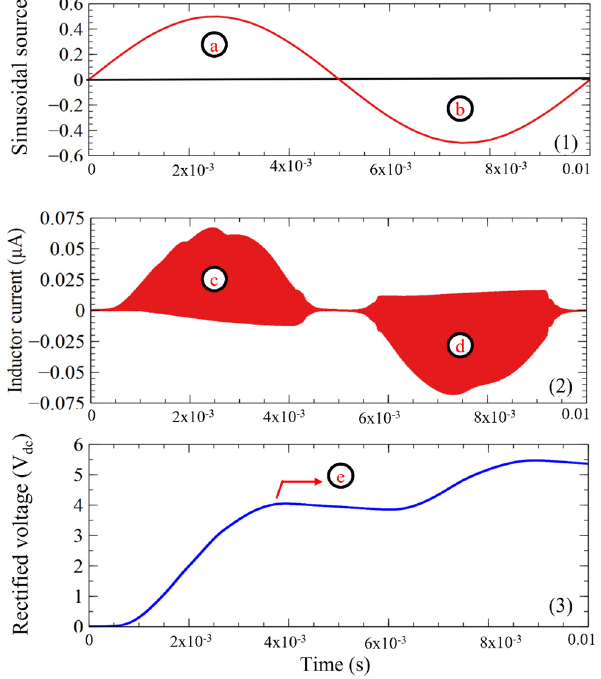
Figure 9. Simulation results with an ideal source ( 1 ). Sinusoidal source, ( 2 ). Inductor current, ( 3 ). Rectified voltage, ( a , b ). Positive, negative cycles, ( c , d ). Inductor current in positive and negative half cycles, ( e ). Rectified voltage.